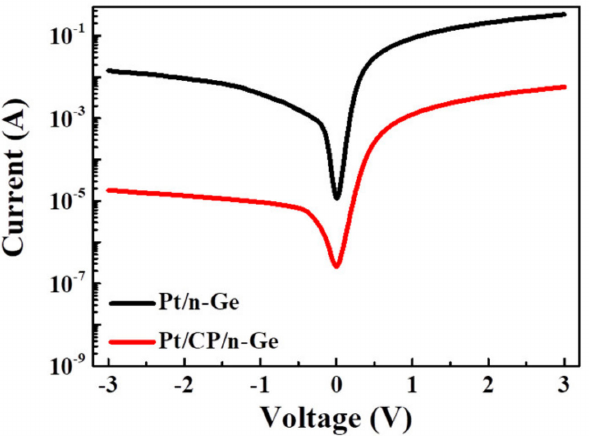
Figure 2. Experimental I–V curves for Pt/n-Ge Schottky diodes with and without a CP